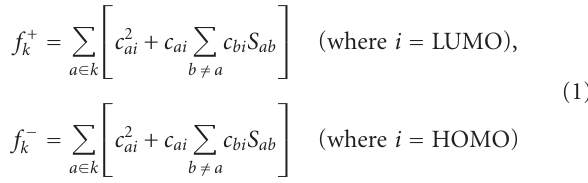
Table 2: Condensed Fukui functions calculated by using the CHIH(small) model chemistry and through the AOMIX molecular analysis